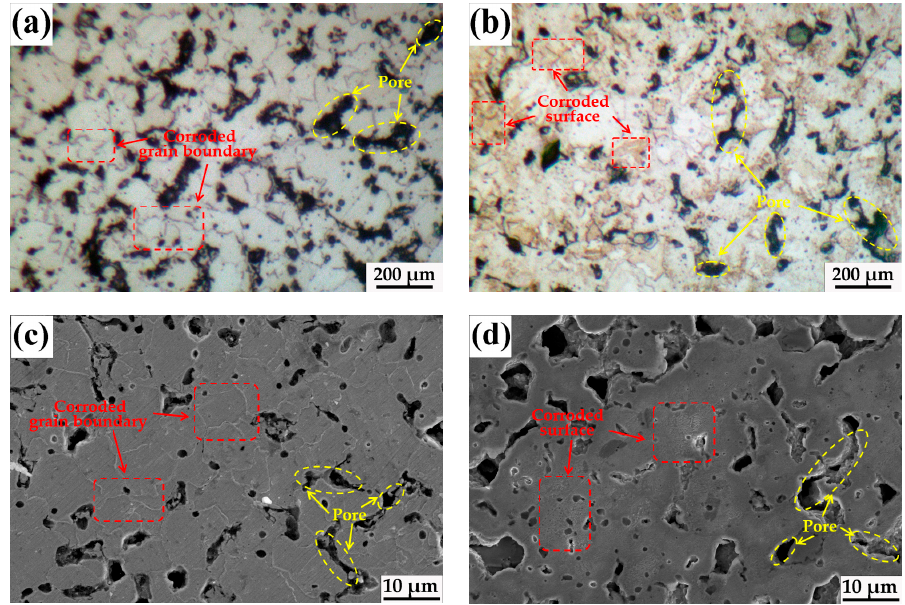
Figure 3. The OM and SEM images of the SSF matrix. ( a , b ) are OM photos of 304 and 430 SSF re- spectively; ( c , d ) are SEM images of 304 and 430 SSF, respectively. respectively; ( c , d ) are SEM images of 304 and 430 SSF,